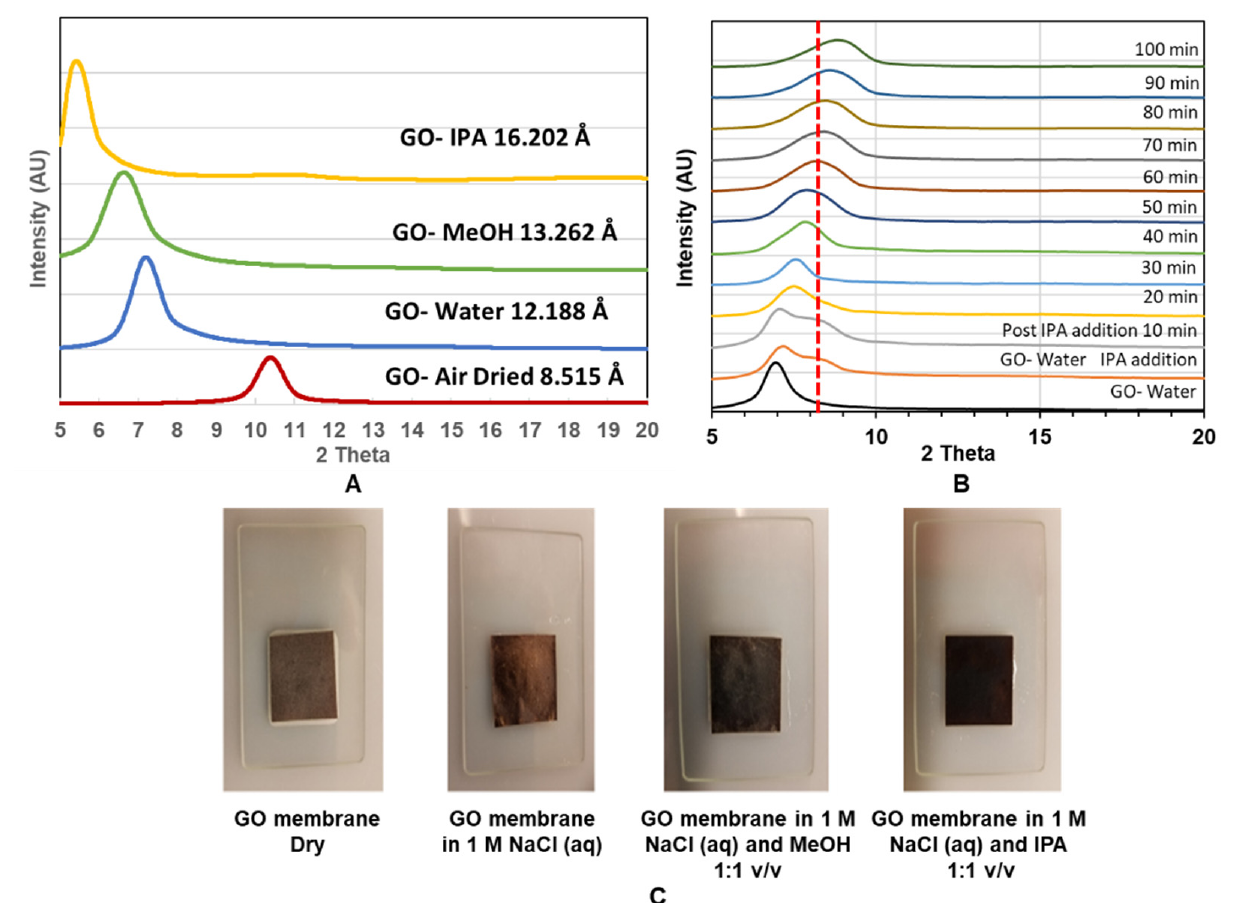
Figure 5. ( A ): XRD of GO immersed in indicated solvents; ( B ): XRD as a function of time for GO immersed in water and peak shift after addition of IPA; ( C ): Color change observed when the GO membrane was immersed in different solutions. Another important experimental observation is that the color of the GO membrane changed from brown to black by the addition of alcohol into water-wetted GO membranes Figure 5C. This suggests a partial reduction reaction of GO to r–GO with the presence of water and alcohol. The initial brown color can be recovered by drying the membrane (not shown). Similar reduction/oxidation reaction induced color change of GO was also reported by another study [18]. To investigate chemical reaction with water–alcohol mixtures, infrared spectra with corresponding XRD were done, as shown in Figure 6. Pristine GO membranes (black curve) show characteristic peaks at 1725 cm − 1 (C=O), 1619 cm − 1 (C=C), and a very broad O-H peak at 3300 cm − 1 . With the addition of water (blue) and water–alcohol (red) mixture, the C=O peak at 1725 cm − 1 disappeared. This reversible result is likely due to the formation of hemiacetals or hydrates (gem-diols) of carbonyl moieties in the presence of water or alcohol. Those are typically unstable so that they are completely reversible. The formation of hemiacetals or hydrates typically needs a negligible amount of acid or base catalyst [45,49,50]. Furthermore, of note is that the O-H stretch at 3200 cm − 1 sharpens and increases to 3300 cm − 1 for both water and mixture, indicating a more ordered system. In the case of water–alcohol mixtures, small peaks at 2900 cm − 1 of C-H stretch and multiples 1500–900 cm − 1 indicate the incorporation of alcohol. The IR spectra return to the same as pristine GO with drying with C=O peak